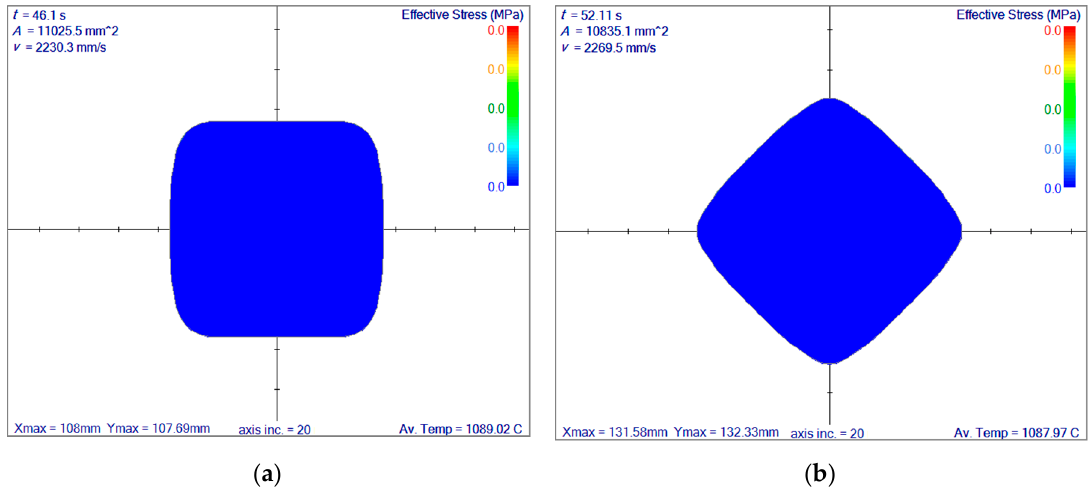
Figure 11. Rotation of 45 degrees before the second part of the reversing rolling simulations.